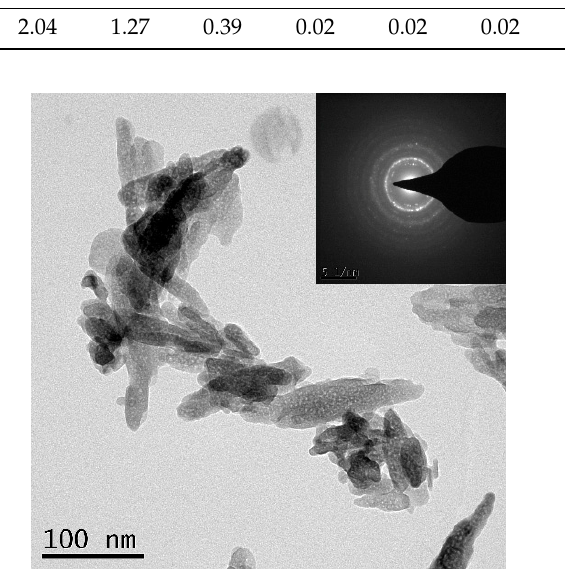
Figure 1. TEM morphology of nano-hydroxyapatite (nHA) particles.